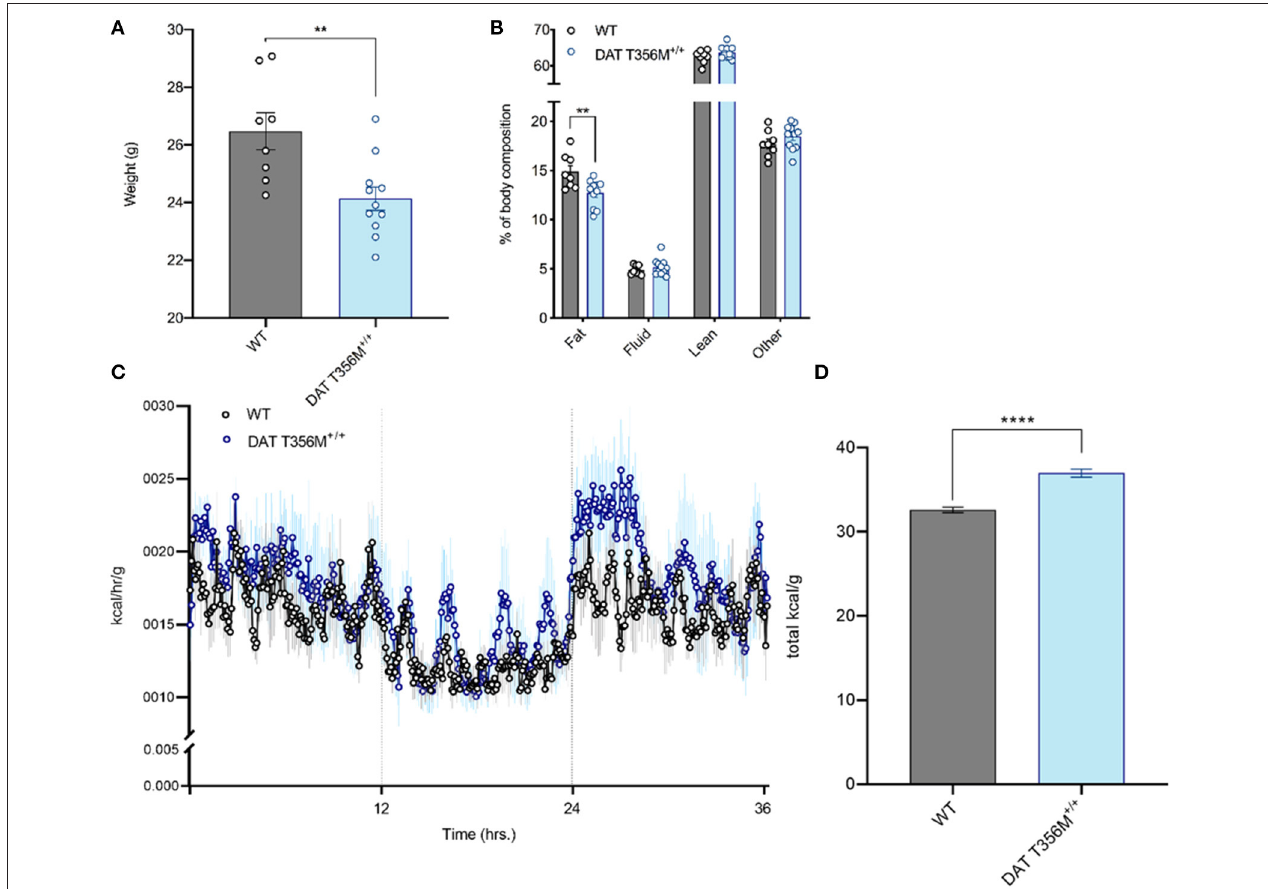
FIGURE 1 | Male DAT T356M + / + mice have reduced body weight, reduced percent body fat, and increased total caloric expenditure. (A) Total body weight is reduced in male DAT T356M + / + mice (WT = 26.48 ± 0.6405g, DAT T356M + / + = 24.14 ± 0.4083g; n = 8 WT, 11 DAT T356M + / + ; t = 3.226, df = 17, ** = p = 0.0050 by Student’s t -test). (B) Percent body fat is reduced in male DAT T356M + / + mice (WT = 14.89 ± 0.6206%, DAT T356M + / + = 12.72 ± 0.4160%; n = 8 WT, 11 DAT T356M + / + ; F (3,68) = 5.373, ** = p = 0.0047 by two-way ANOVA followed by Sidak’s multiple comparisons test). (C) Caloric expenditure per gram of body weight binned in 5-min intervals over the course of 36h. Vertical lines at 12 and 24h represent the start and end of the light cycle, respectively. The blue circles represent the mean value for DAT T356M + / + mice ( n = 5) and the black circles represents the mean value for WT mice ( n = 5). The light gray and light blue lines represent the SEM. (D) Total caloric expenditure is increased in male DAT T356M + / + mice as measured by indirect calorimetry (WT = 32.60 ± 0.3298 kcal/g,